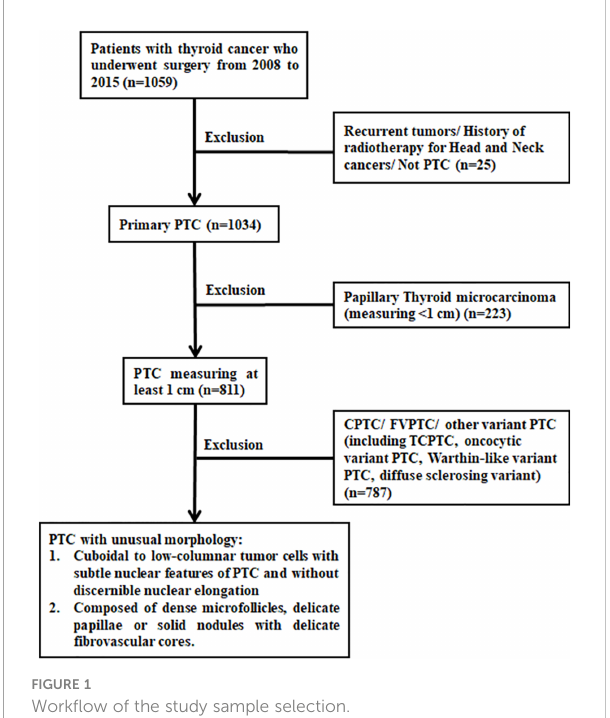
FIGURE 1 Work fl ow of the study sample